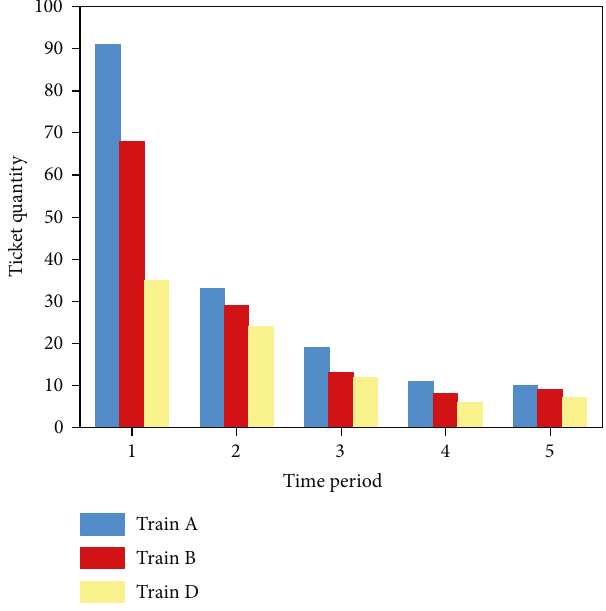
Figure 7: Ticket allocation quantity for OD pair